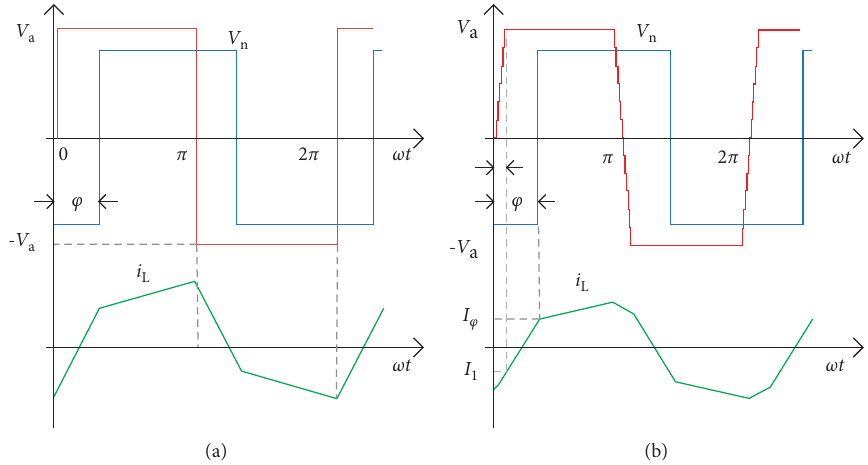
Figure 5: Schematic diagram of working principle. (a) Conventional DAB and (b) MMC-based DAB.